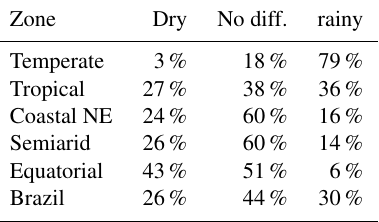
Table 2. Frequency of higher maximum temperature during dry and rainy days.